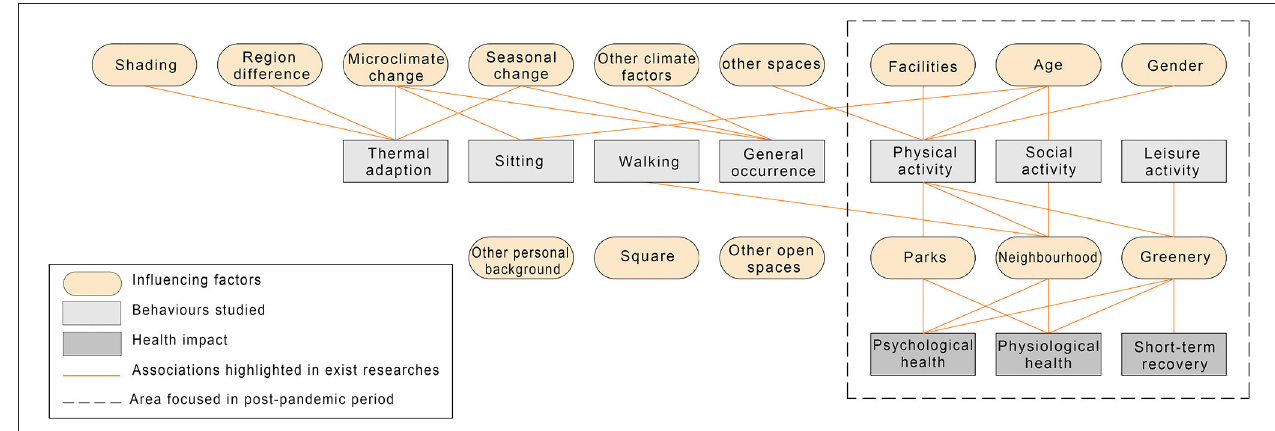
FIGURE 8 | Behavior study in post-pandemic period.